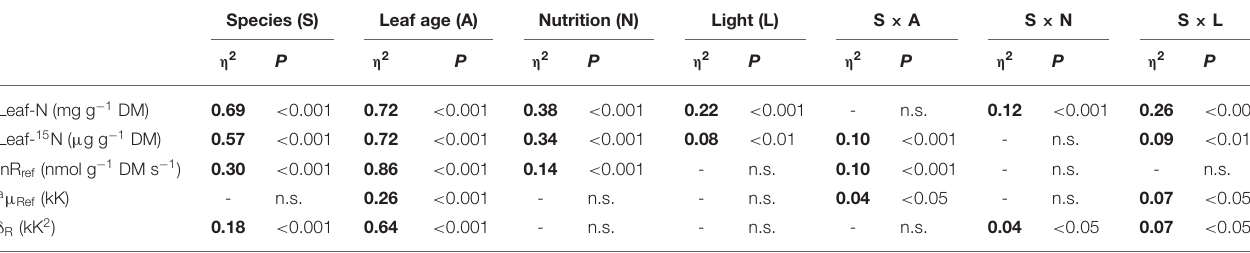
TABLE 3 | Results of analysis of variance (ANOVA) for leaf nitrogen and respiratory parameters.